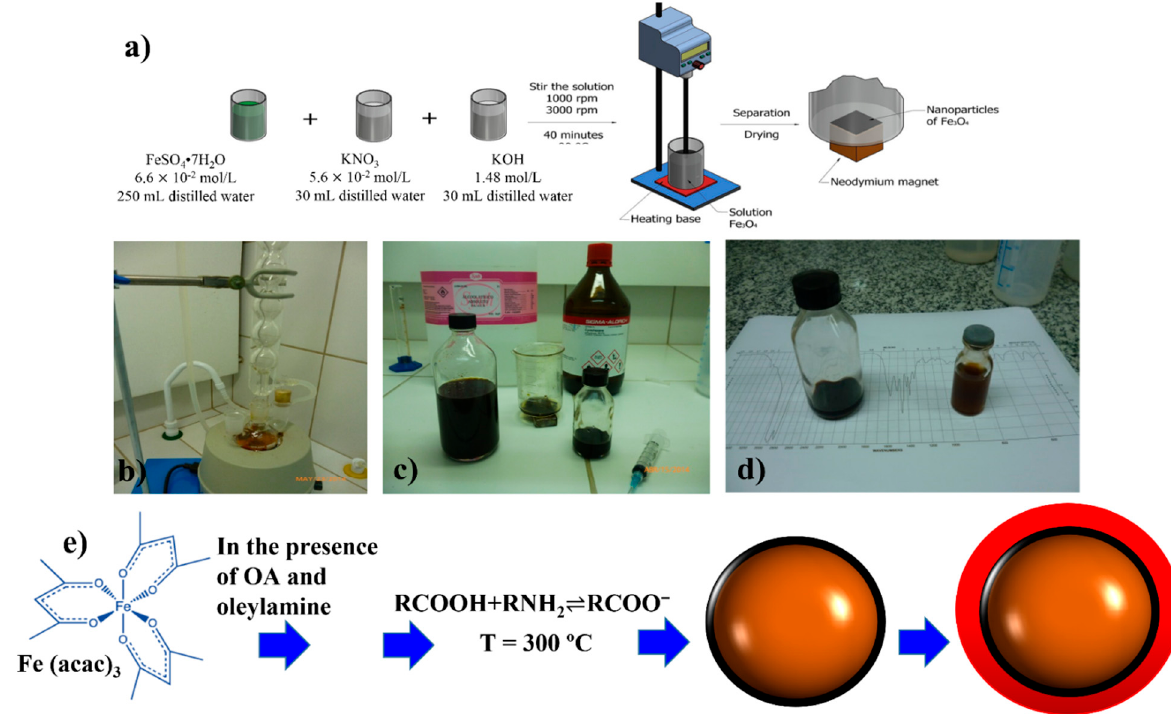
Figure 1. ( a ) Scheme for the co-precipitation method (reproduced with permission from Elsevier [34]). ( b – d ) Steps to synthesize Fe 3 O 4 NPs by thermal decomposition method. ( e ) Biding model of surfactants to Fe 3 O 4 core. Hydrophobic NPs in organic medium (black layer) and hydrophilic surface modification (red layer). Fe(acac) 3 indicates the organic precursor of iron (III) acetylacetonate and OA is the oleic acid.